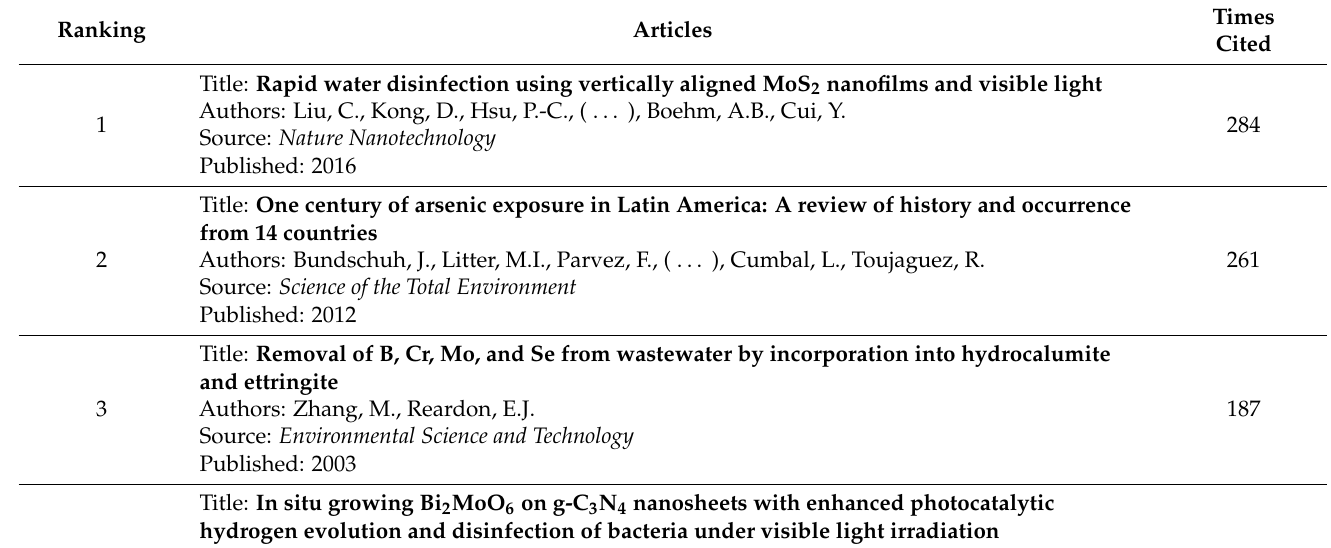
Table 6. The top 10 most cited